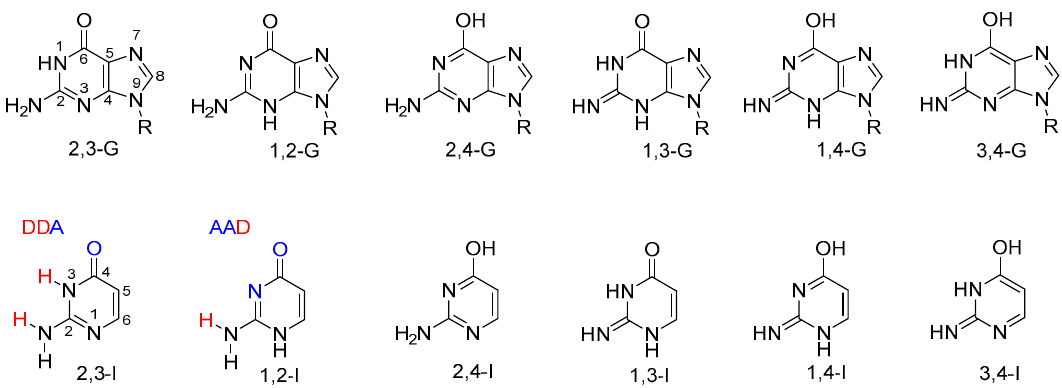
Figure 1. Possible tautomers of 9-substituted guanine ( top ) and analogous tautomers of isocytosine ( bottom ). Hydrogen-bonding donors (D) and acceptors (A) are highlighted in the structures of the two major isocytosine tautomers.